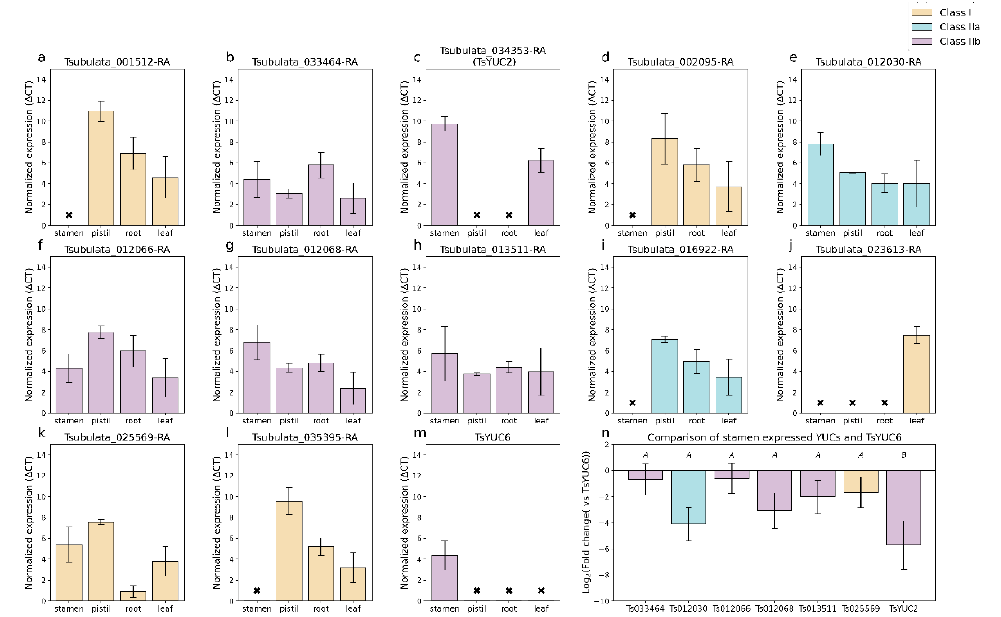
Figure 8. Expression of the YUCCA family in the developing leaves, apical root, immature stamen, and immature pistils of Turnera subulata ( a – m ). Bars are color-coded according to which YUCCA subfamily they belong to (see key). These values represent the average normalized expression, calculated using housekeeping genes β -tubulin and UEVD1 . As these represent normalized expression (gene of interest—housekeeping gene), higher values represent lower levels of expression. X = not expressed. For ( n ), all means sharing a letter are not significantly different following a single factor ANOVA and Tukey’s test. F 7,16 = 247.61, p < 0.0001. Values represent the Log 2 (Fold change). Error bars represent the standard error. Names were abbreviated in (n) to improve readability.